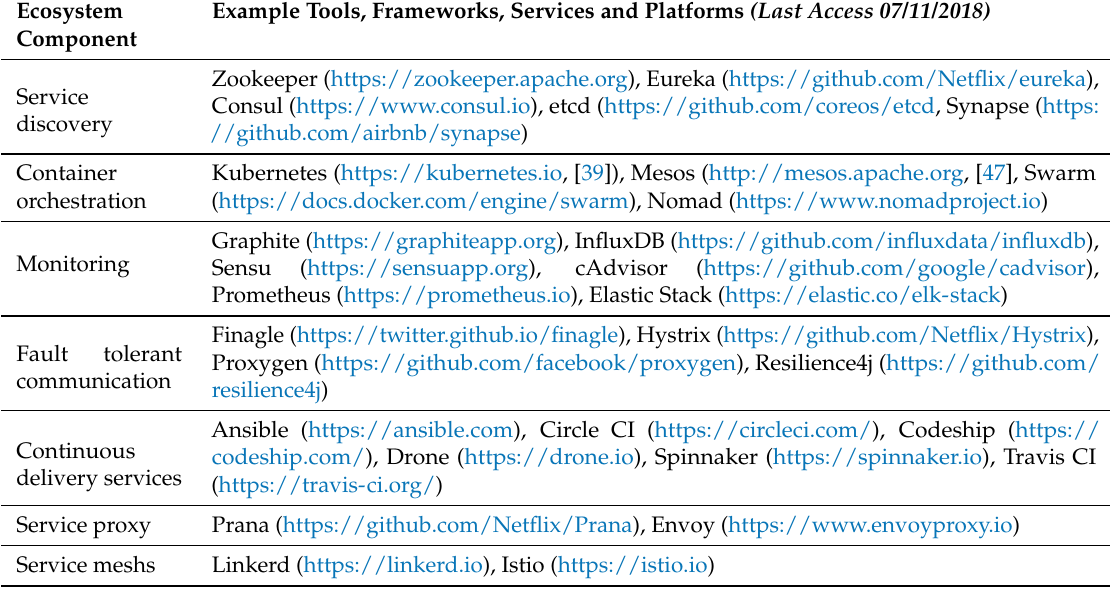
Table 3. Some observable microservice engineering ecosystem components (adapted from [31]). Ecosystem Example Tools, Frameworks, Services and Platforms (Last Access 07/11/2018) Component